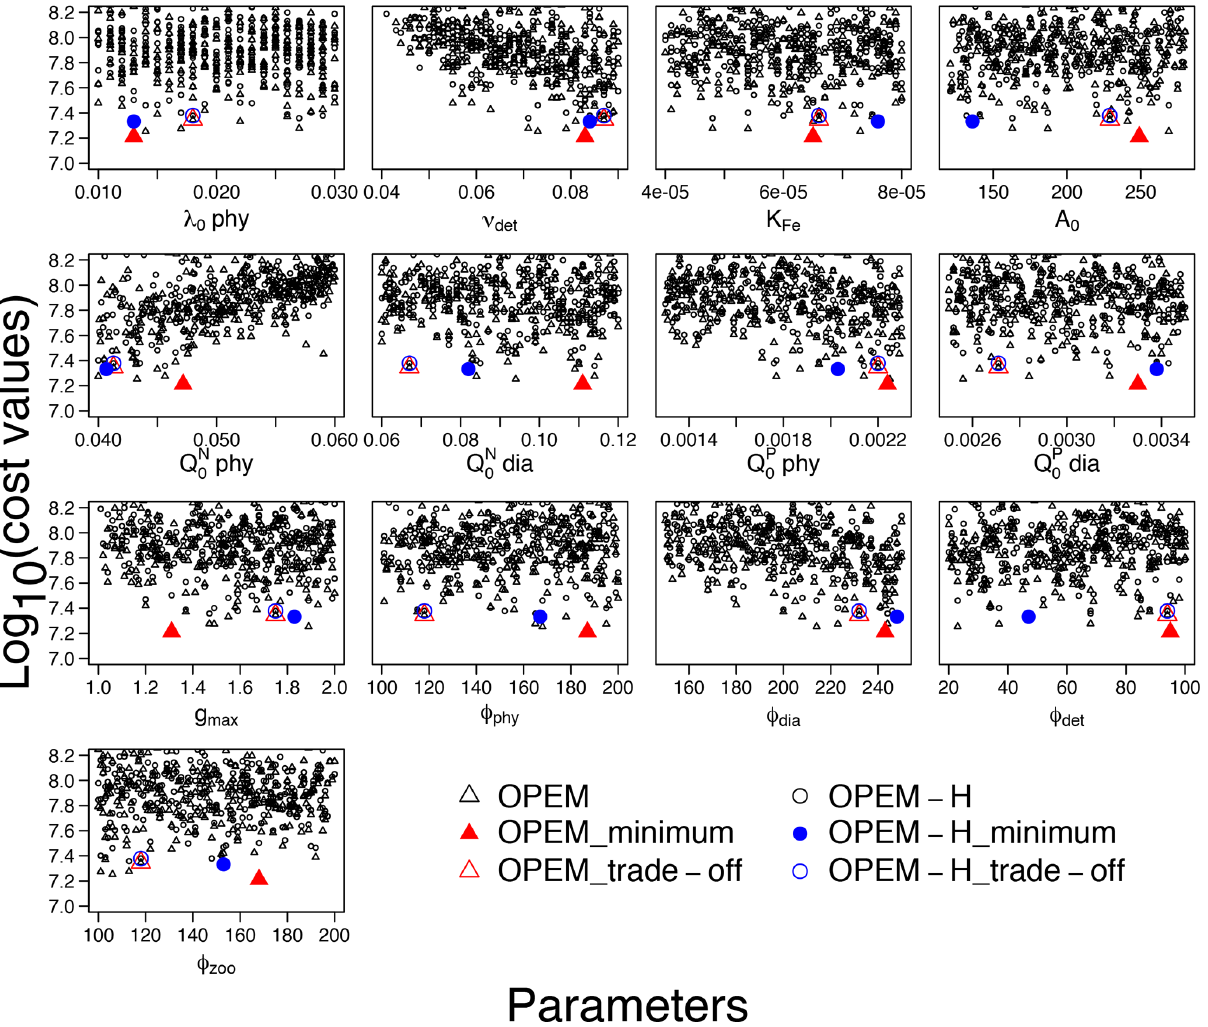
Figure 8. Lower parts (cost < 10 8 . 2 ) of cost–value distributions for the parameter ranges in Table 1. Solid red triangles and blue circles represent the minimum-cost simulations in OPEM and OPEM-H, respectively, and open red triangles and blue circles are the trade-off simulations. Note that the trade-off simulations share the same parameter combination but have slightly different cost–value